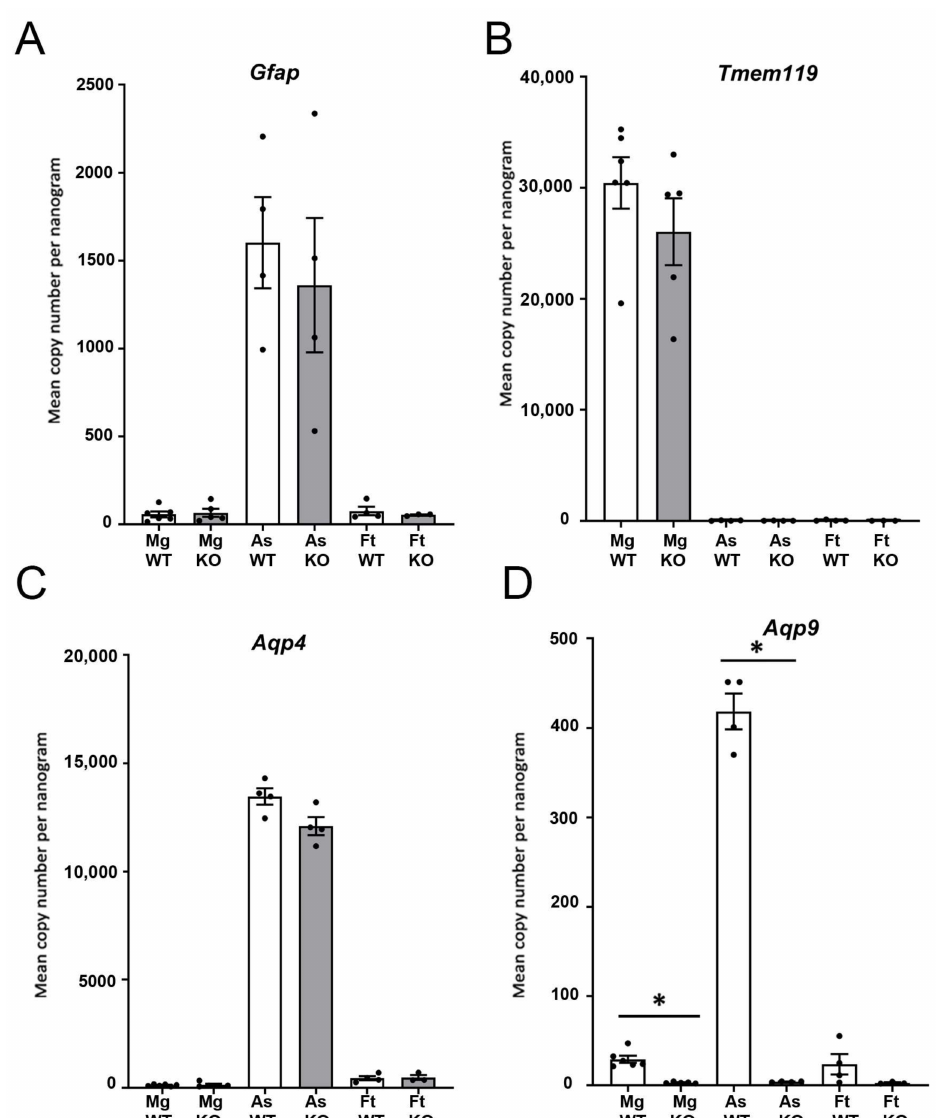
Figure 3. Gene expression in magnetic bead-separated cells from WT and Aqp9 − / − mouse brains ( A ) The astrocyte marker Gfap is highly expressed in the astrocyte fraction in both genotypes. ( B ) The microglial marker Tmem119 is only expressed in the microglial cell population of both genotypes. ( C ) Aqp4 is prominently expressed in the astrocyte fraction in both genotypes. ( D ) Aqp9 expression is seen in the WT microglia and astrocytes, whereas Aqp9 − / − cell populations show no expression. Bars are mean ± 2SEM, * p <